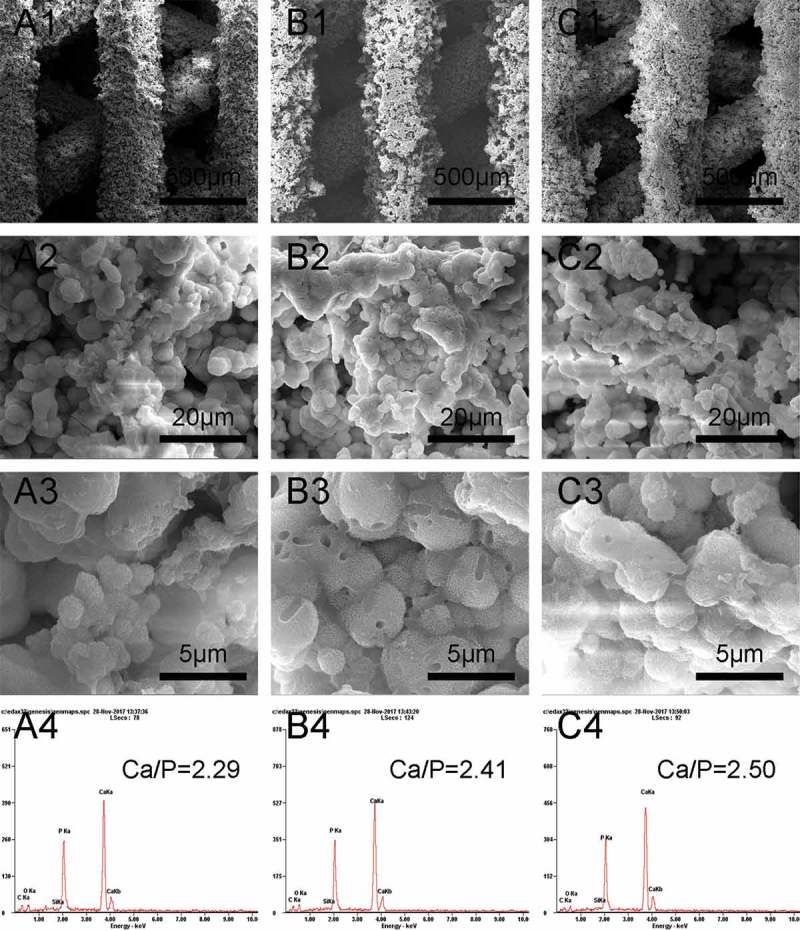
SEM images of β-Ca2SiO4 scaffolds sintered at (A1–A3) 1000 °C, (B1–B3) 1100 °C, and (C1–C3) 1200 °C after immersed in SBF for 7 days; EDS analysis of β-Ca2SiO4 scaffolds sintered at (A4) 1000 °C, (B4) 1100 °C, and (C4) 1200 °C after immersed in SBF for 7 days.